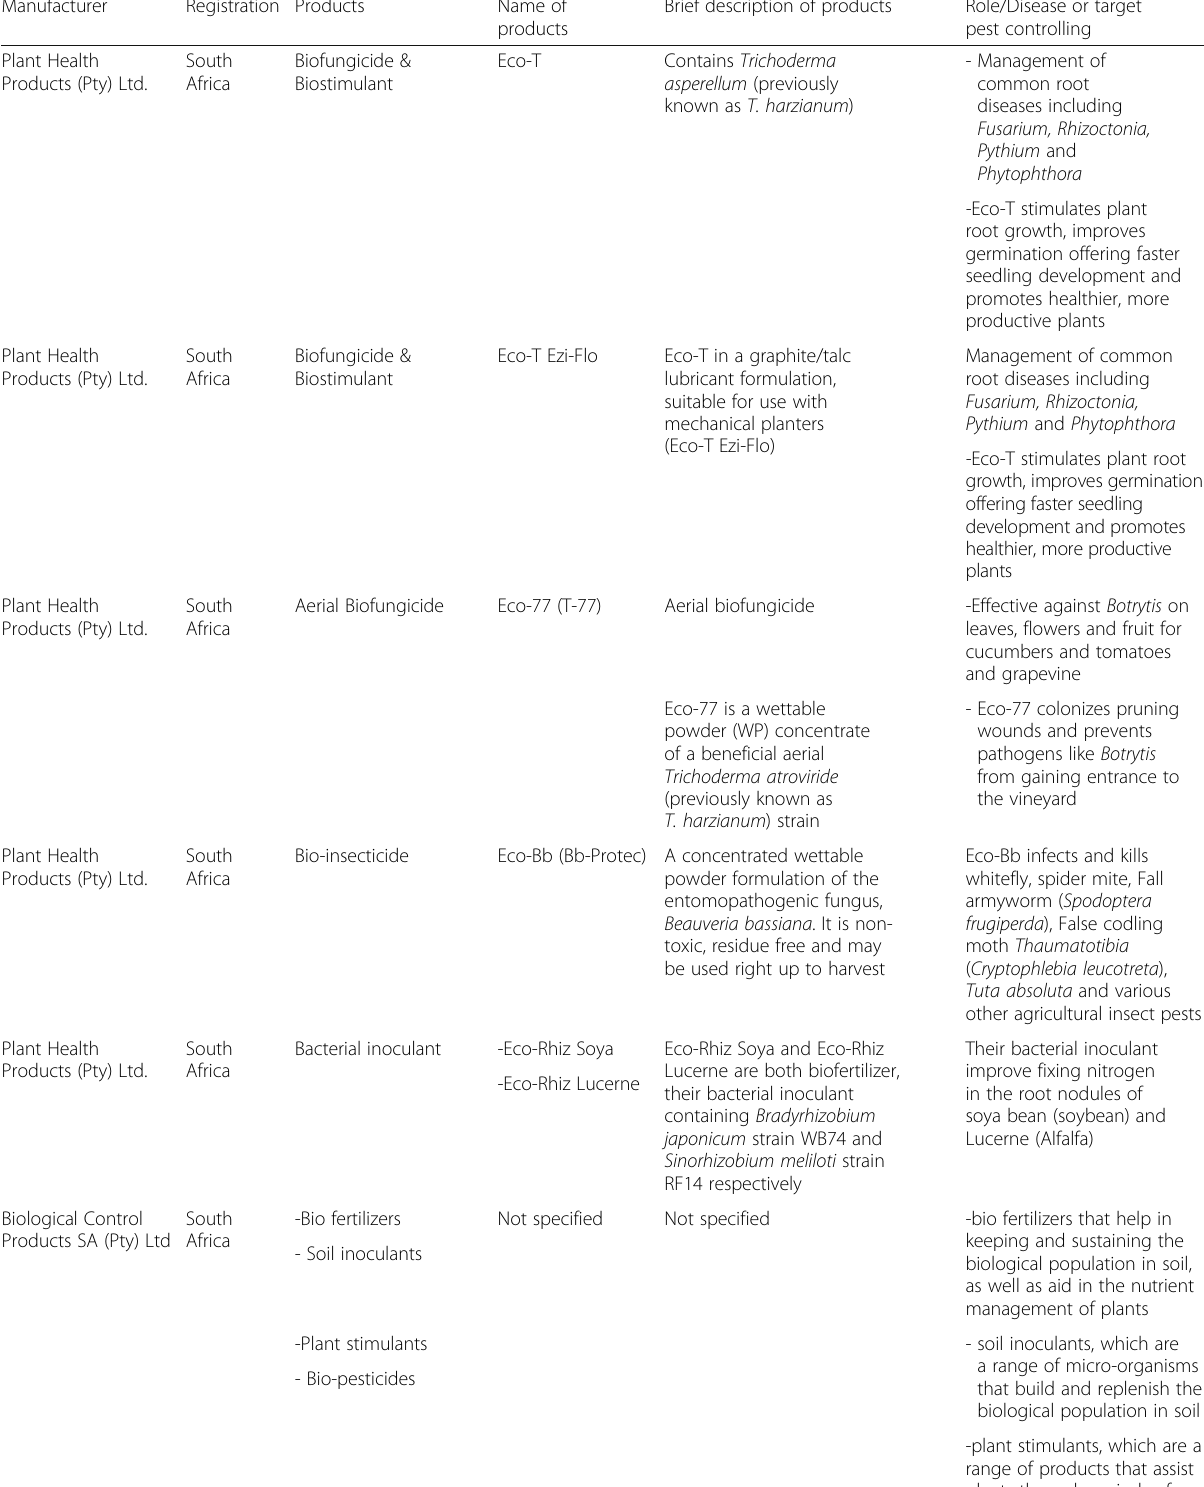
Table 2 Presentation of manufacturers in Africa and commercialized